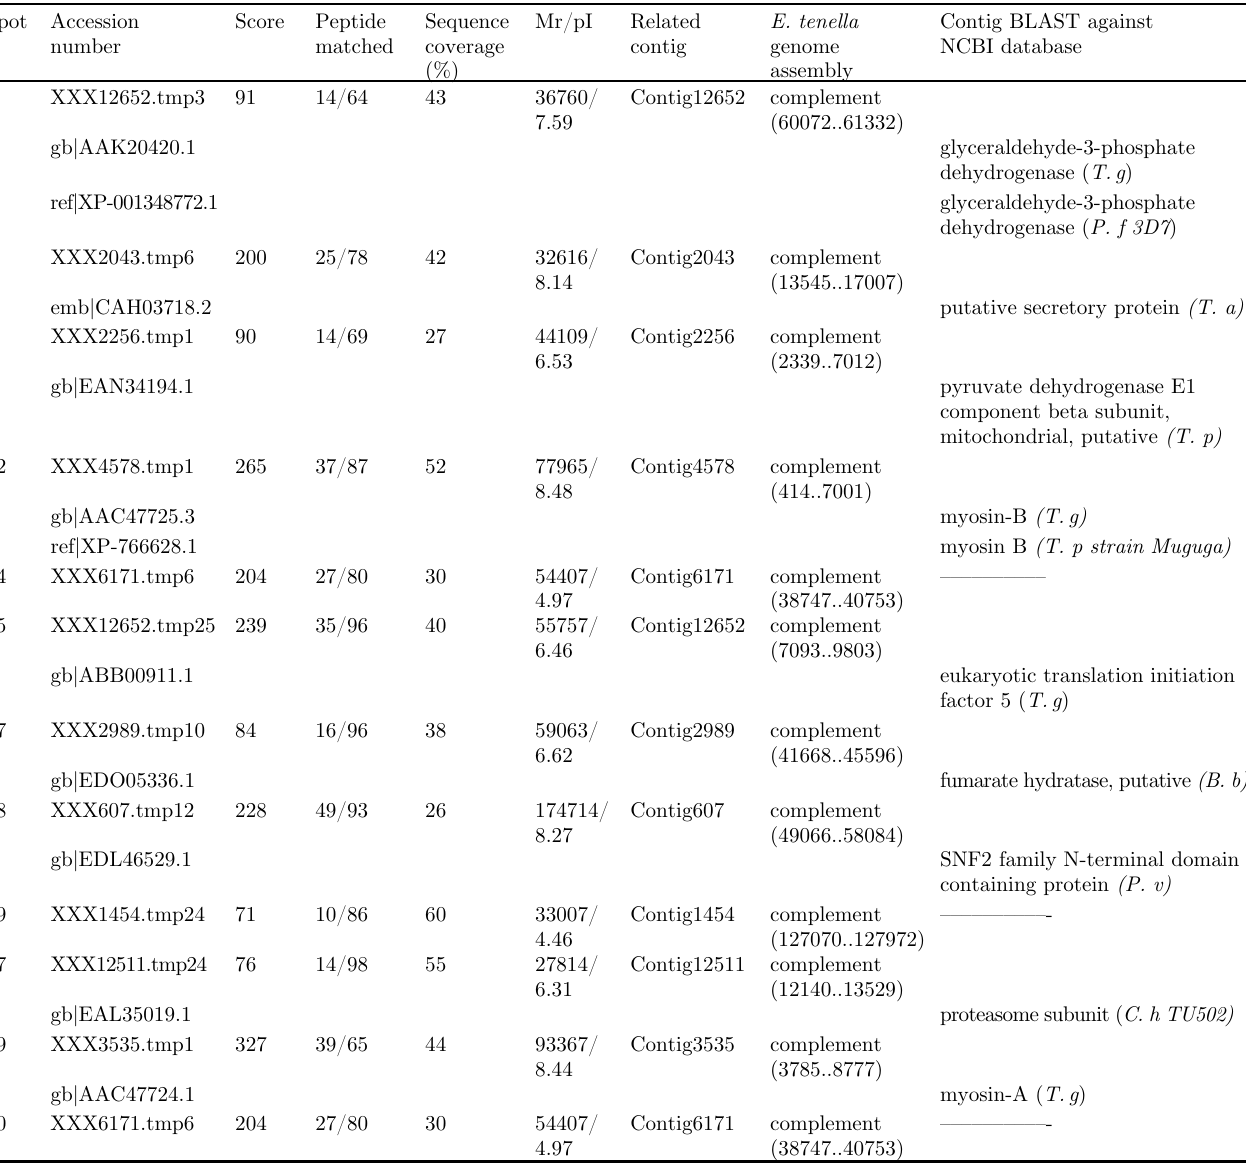
Table 2. Identi fi cation of unsporulated Eimeria tenella oocyst proteins by E. tenella protein database from E. tenella